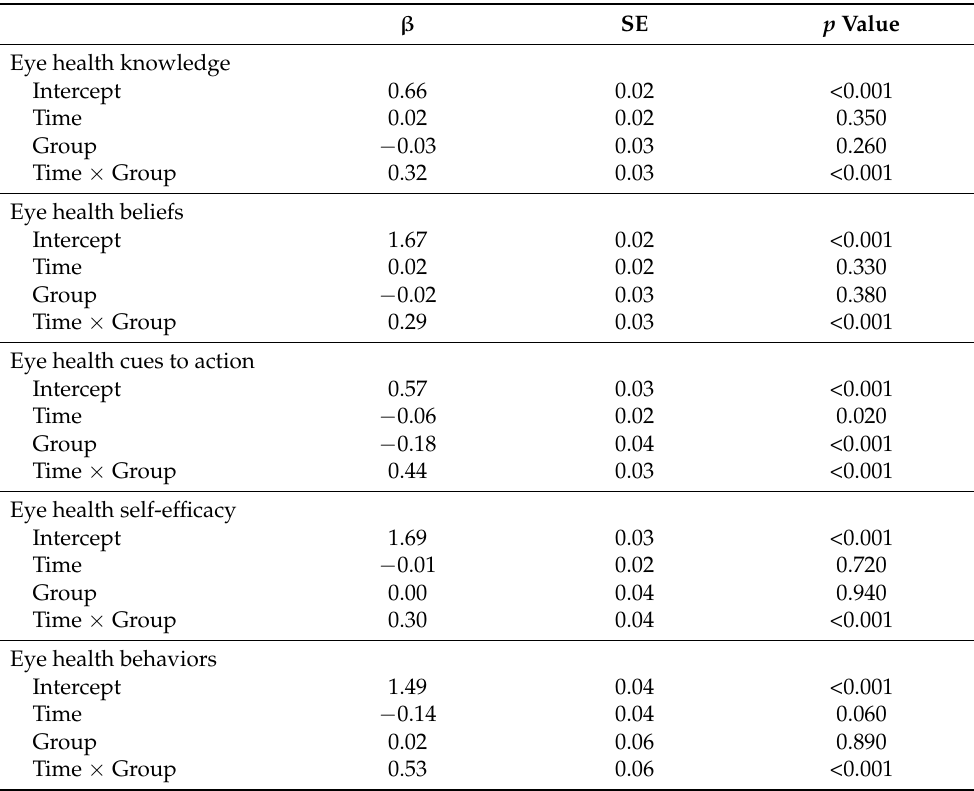
Table 4. Multivariate analysis of children’ eye health knowledge, beliefs, cues to action, self-efficacy, and behaviors.